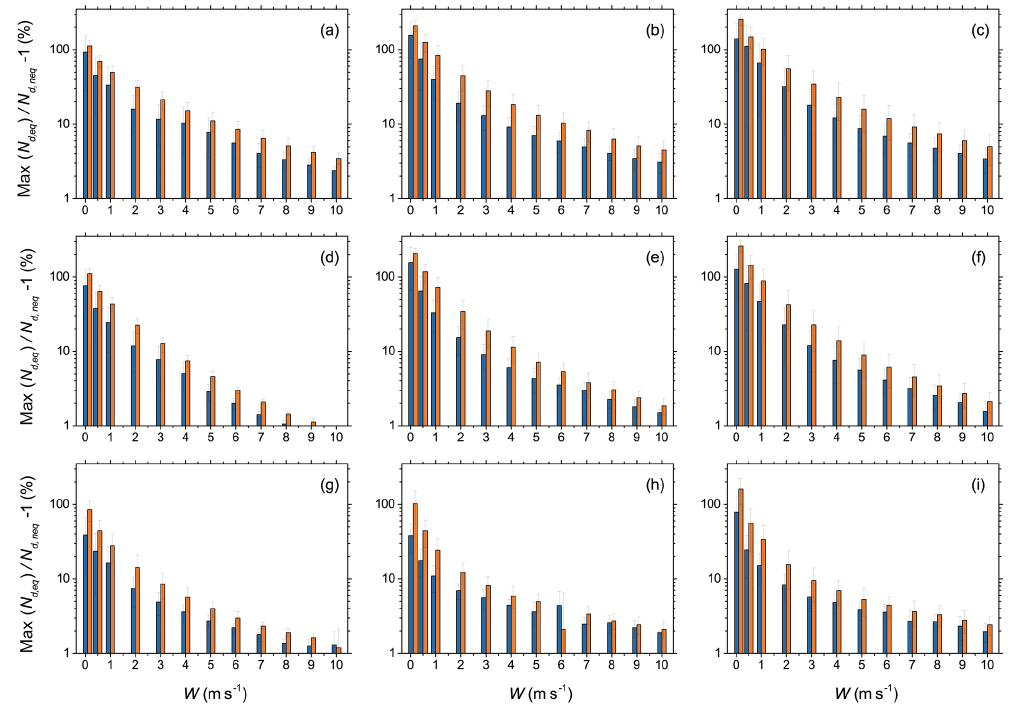
Figure 10. Overestimation of N d when the population is estimated assuming equilibrium at the time of maximum supersaturation, max (N d,eq ) , compared with N d,neq at the time of maximum supersaturation (blue) and at the end of the simulation (orange), for the range of updraft velocities. Values correspond to the MP 5 , 1 (a–c) , MP 1 , 5 (d–f) and HP 5 , 5 (g–i) case studies. The mixture of the aerosol population was either internal (left panels) or external as in Ext 1 (middle panels) and Ext 2 (right